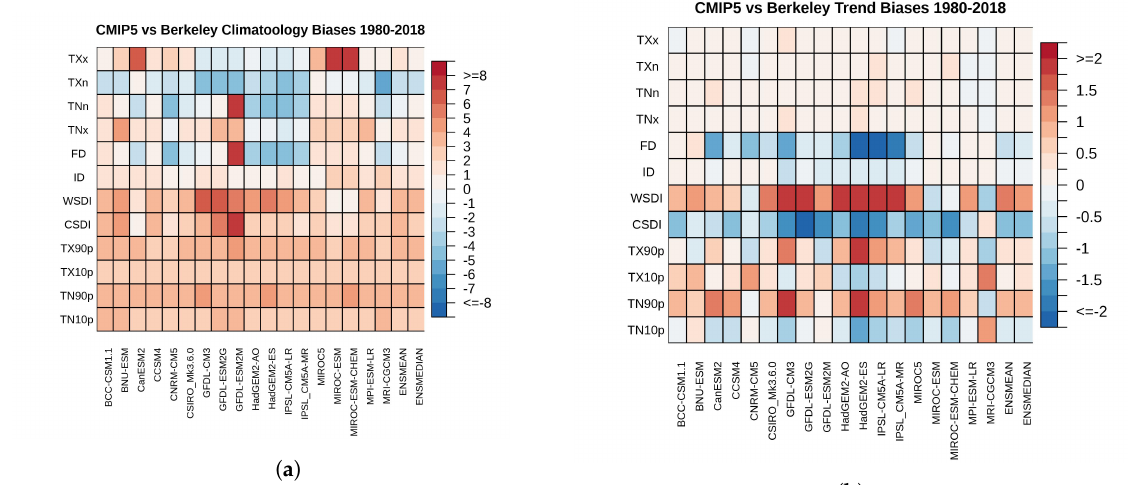
Figure A10. Portrait diagrams of domain-averaged biases of the 1980–2018 climatology ( a ) and the average decadal trend ( b ) of temperature indices simulated by the CMIP5 models with respect to Berkeley observational data set. The biases are spatially averaged over MENA region land grid